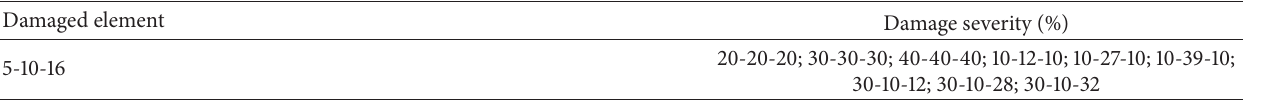
Table 9: Test samples for fuzzy system of damage condition assessment with multiple